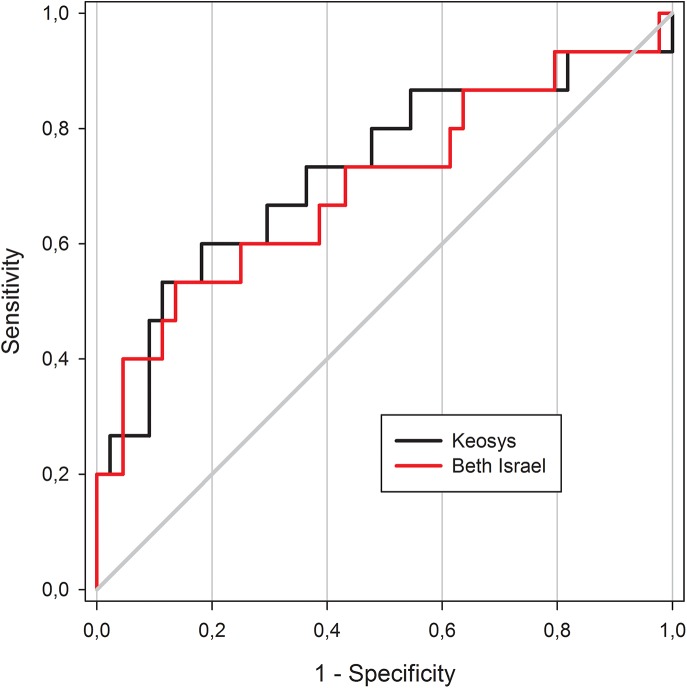
ROC curves according to software ROC curves using TMTV041 with Beth Israel plugin (red line) and the commercial software (black line).